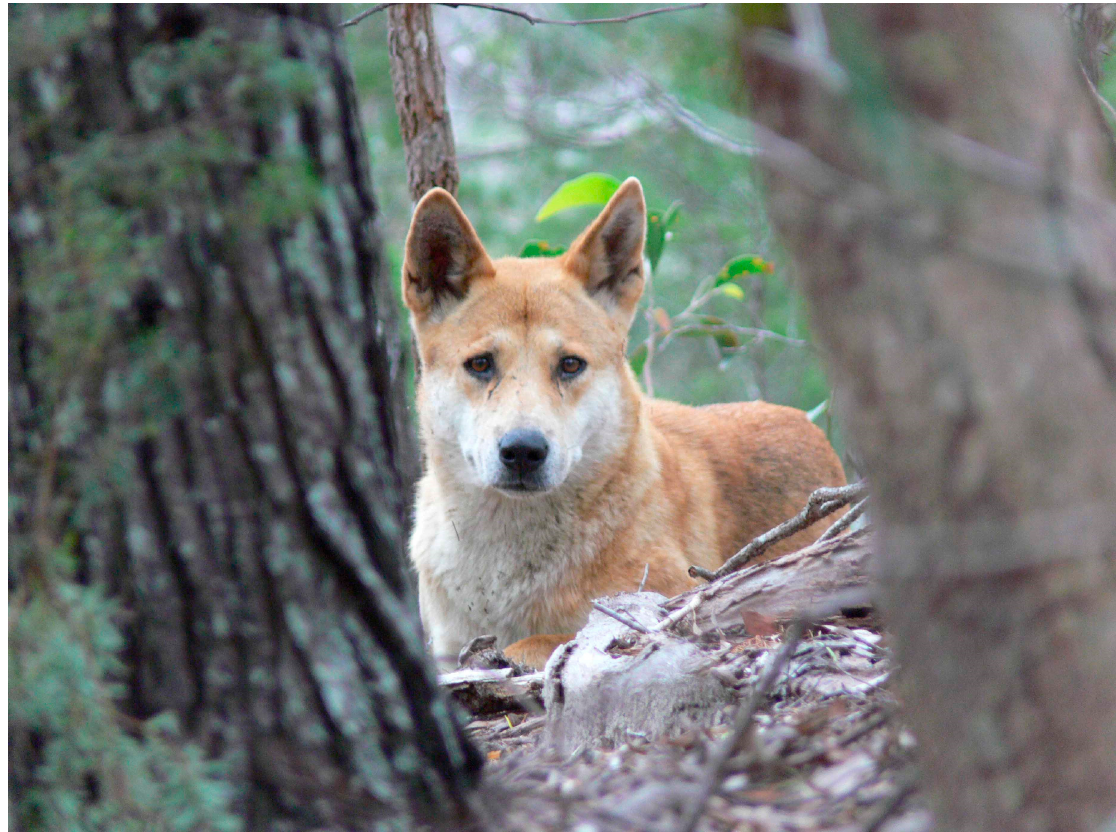
Figure 1. A wild dingo ( C. dingo ). This photograph, taken in 2007 on K’gari (Fraser Island), is of a five- to six-year-old male. Credit: Rob Appleby.